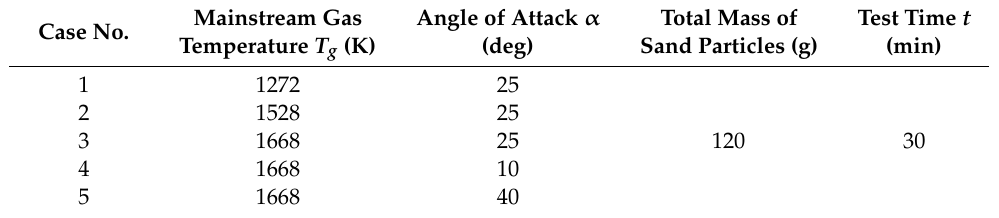
Table 2. Deposition test variables.